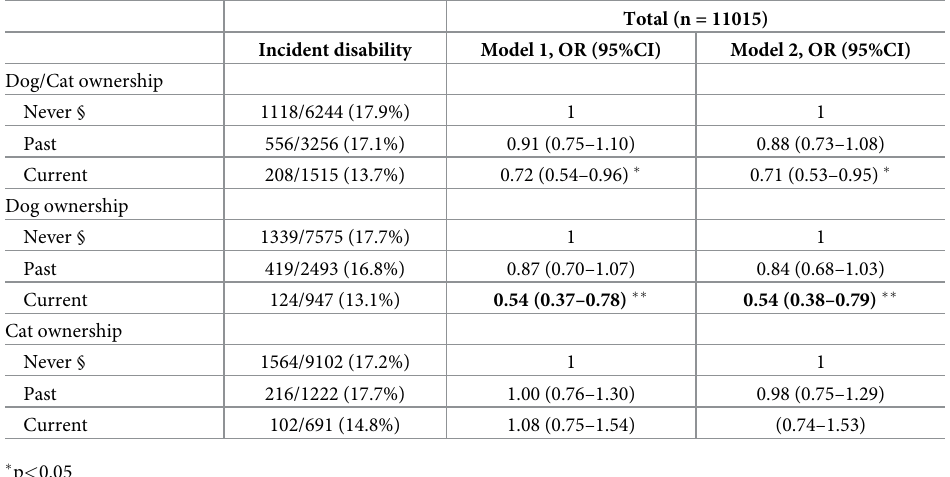
Table 2. Logistic regression models estimating the net effects of dog and cat ownership on the onset of disability. Model 1 includes controls for socio-demographic variables. Model 2 also adds controls for health at